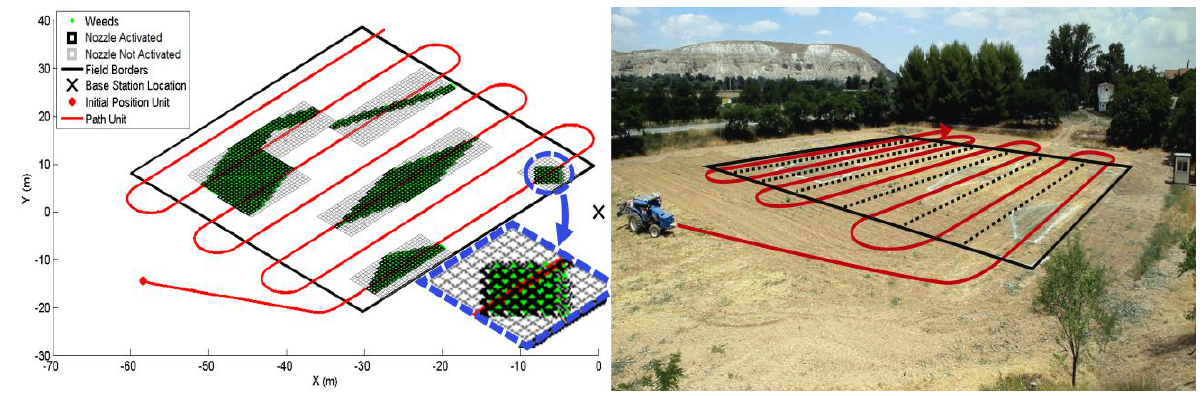
Figure 6. Mission trajectory and sprayer boom activation status.